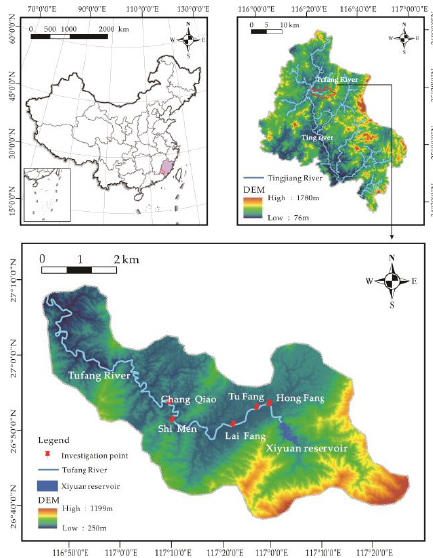
Figure 1. The river system distribution of Tufang River System.